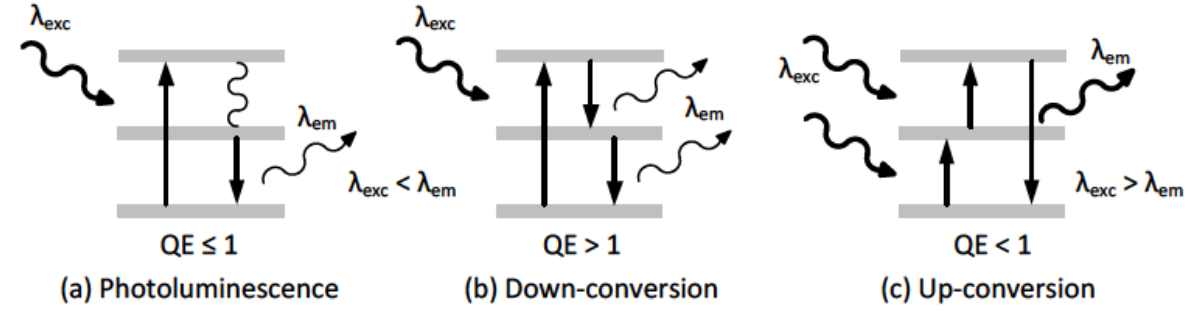
Figure 9: Schematic representation of spectral modification techniques, adapted from [78] (a) Photoluminescence (PL): involving the non- radiative relaxation via phonon emission, corresponding to the loss of excess energy (b) Down-conversion (DC): a two-step emission pro- cess allowing more than one photon to be generated for each excitation photon. (c) Up-conversion (UC): a sequential absorption process whereby multiple low-energy excitation photons result in the radiative emission of a single high-energy photon.